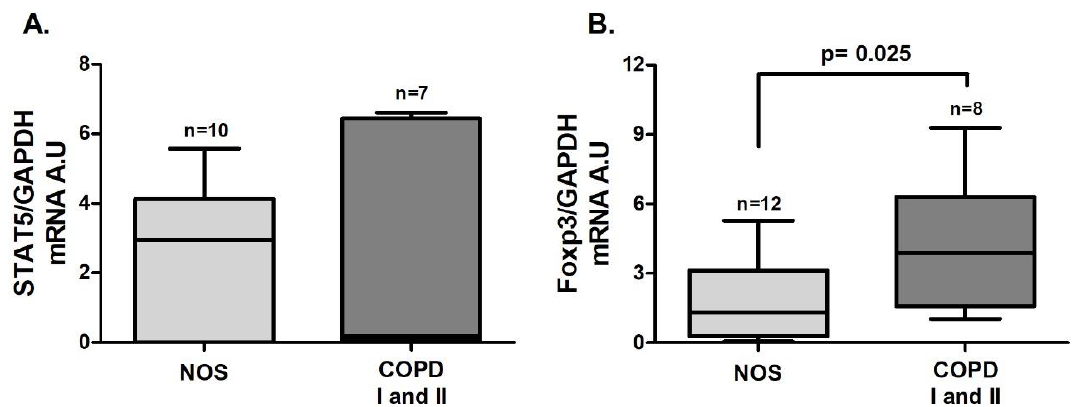
Figure 5. Treg transcription factors in lung tissue samples: Treg transcription factors gene expression in lung tissue sam- ples. ( A ) No differences were observed for STAT5 gene expression (Mann–Whitney test); ( B ) increased Foxp3 gene expression ( p = 0.025, t -test) in the COPD I and II group. The data are expressed as the median and interquartile range. A.U: Arbitrary Units.